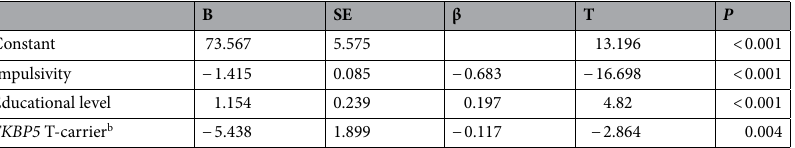
intron 7 were not significantly different between the genotype groups of FKBP5 rs1360780 (CC vs. T-allele car- riers) (Table 1). In addition, no significant differences in DNA methylation levels at FKBP5 intron 7 were found between groups with higher and lower childhood trauma (Supplementary Table S2) or between genotypes (the TT/TC vs. CC genotype) of SNP rs1360780 depending on childhood trauma (Supplementary Table S3).